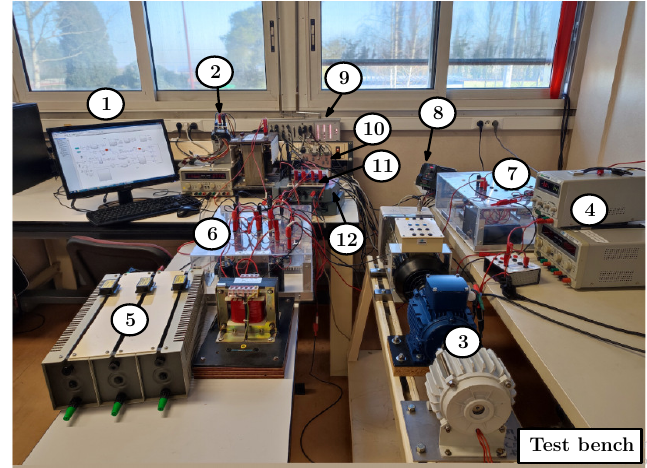
Figure 10. Experimental test bench: 1. PC interface; 2. PV simulator; 3. WT simulator; 4. ESS; 5. Load; 6. DISO converter; 7. Bidirectional converter; 8. Frequency variator; 9. dSPACE 1104 board; 10. Controller board; 11. Current sensor; 12. Voltage